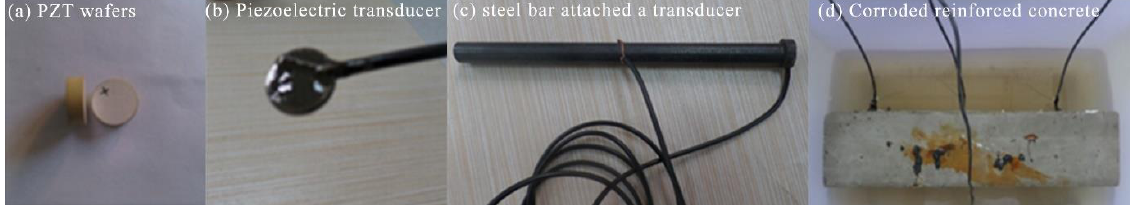
Figure 2. Photographs of the piezoelectric transducer and corroded reinforced concrete. ( a ) PZT (Lead Zirconate Titanate) wafers; ( b ) Piezoelectric transducers; ( c ) Steel bar attached a transducer; ( d ) Corroded reinforced concrete.